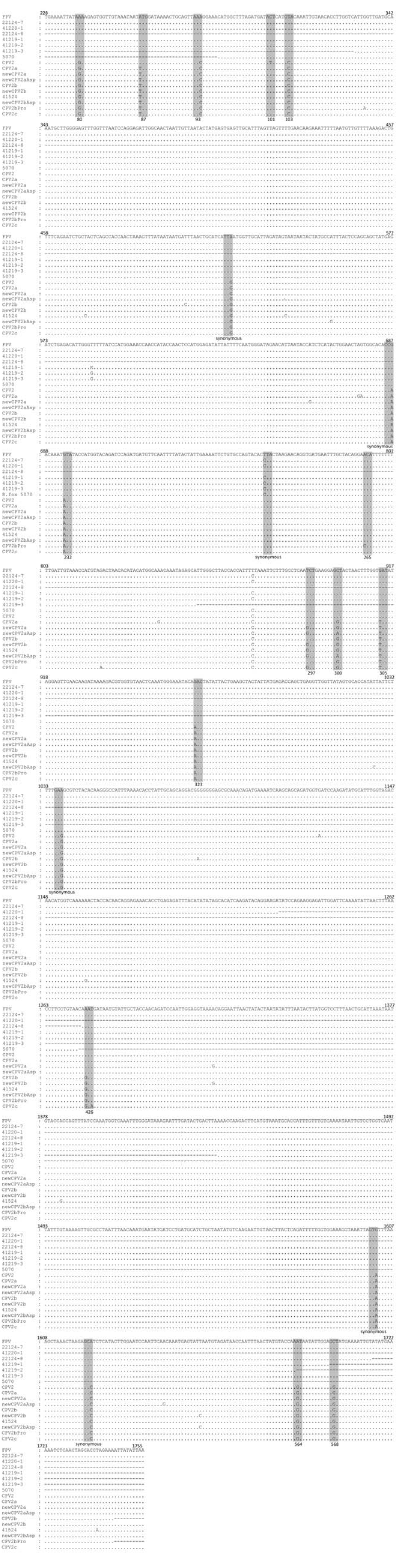
Figure 3. Multiple alignment of VP2 encoding sequences (nucleotides 228 to 1755). CLUSTAL W was used to align vp2 nucleotide sequences from wild carnivore parvoviruses characterized during this study and from parvoviruses representatives of each